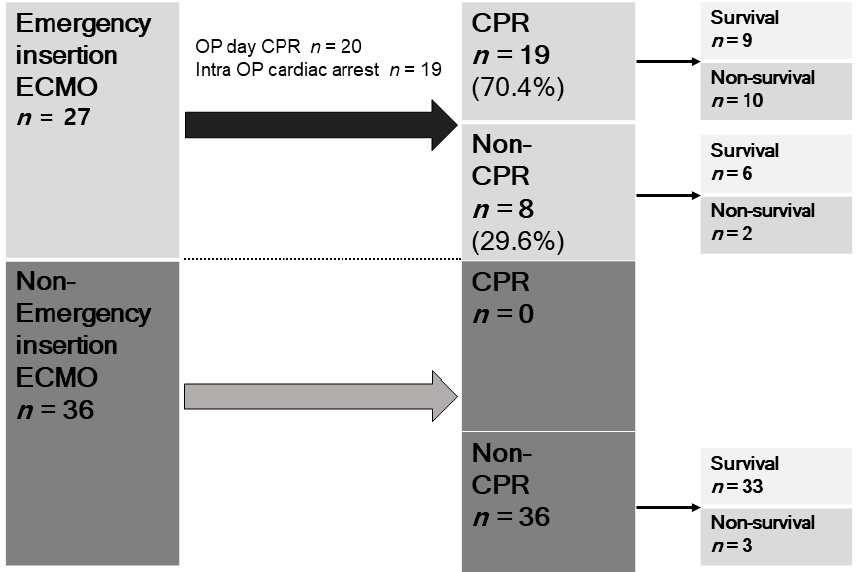
Figure 1. The proportion of survival and non-survival group with or without CPR, in according to the timing of ECMO.